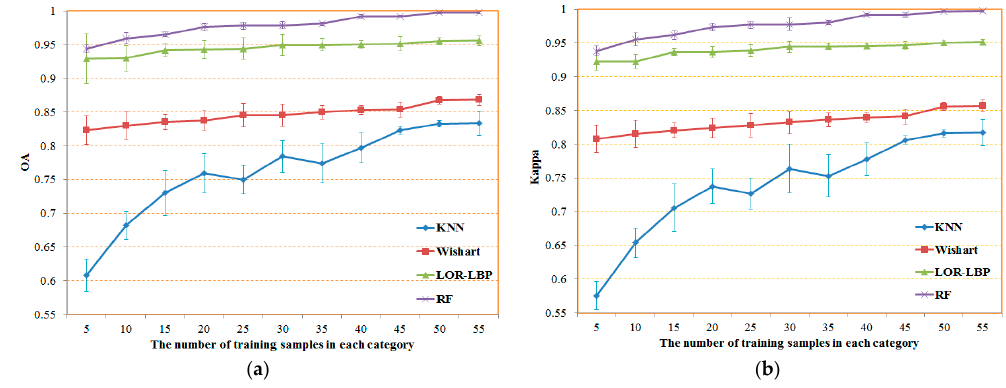
Figure 7. OA and Kappa curves with different number of training samples for the classification algorithms: ( a ) OA; ( b ) Kappa. algorithms: ( a ) OA; ( b )